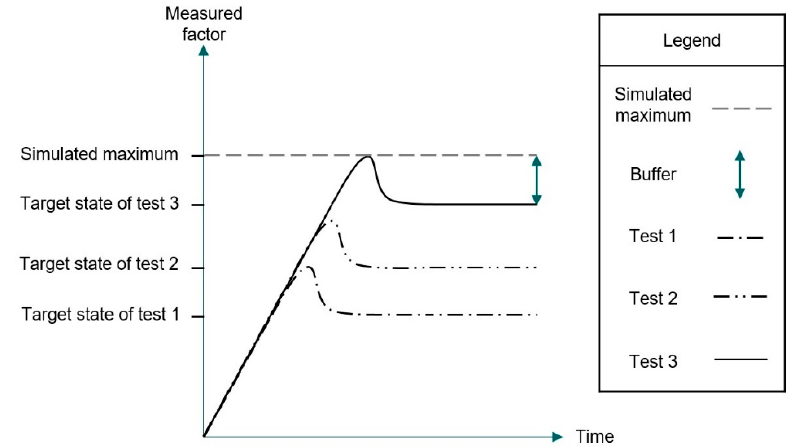
Figure 5. Illustration of a definition of a buffer for a given factor based on system overshoot.